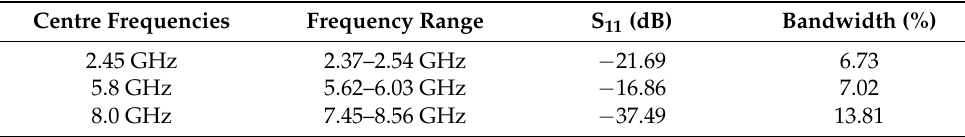
Figure 14. Impedance bandwidth of the proposed antenna. Table 2. Bandwidth analysis of the proposed antenna.